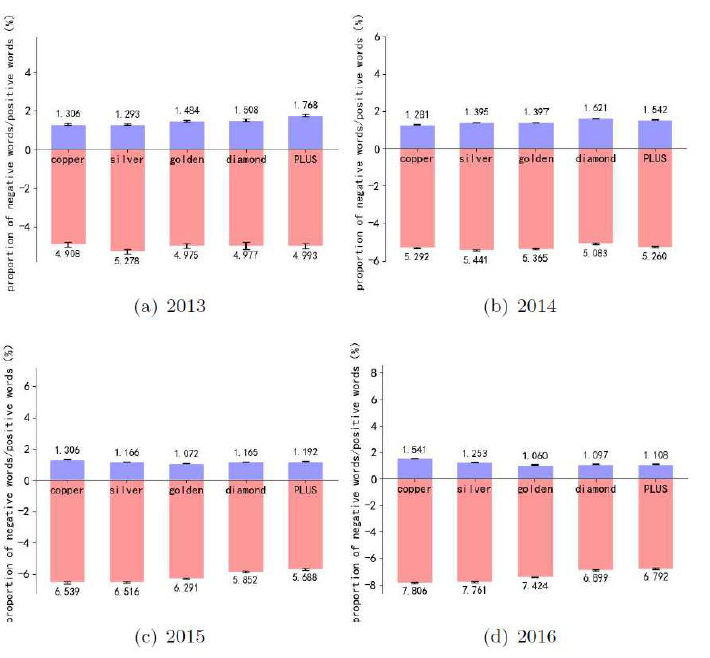
Figure A9. Average proportions for positive and negative emotion words in negative reviews of 2013–2016. The bars on the upper side of the x -axis represent the percentages of positive emotion words, while those on the underside are the negative ones. The five groups, from left to right, refer to user levels, that is, copper, silver, golden, diamond and PLUS. The absolute value of the y -axis means the percentage of emotional words. Moreover, the error bar is calculated by the sample standard deviation. As the four bar plots show, the same tendency is performed in the negative degree and is regular in the positive degree in 2015–2017. Regarding the compared performances in consecutive years, it reflects that JD has emphasized the paid users’ experience more and provided more rights or guarantees for them in recent years.